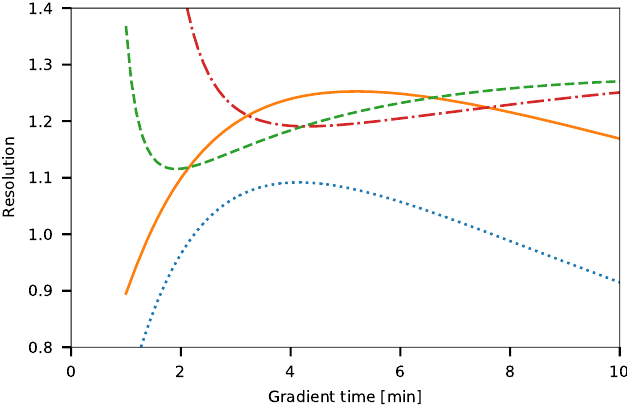
Figure 9. A resolution of different Triton X-100 oligomer pairs. The number of ethylene oxide units: 5/6 (dotted line), 8/9 (solid line), 15/16 (dashed line), and 21/22 (dashed-dotted line).